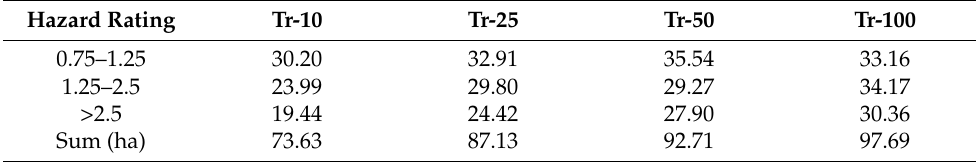
Figure 13. Flood hazard maps based on different return period rainfall events. Table 2. The allocated area (ha) to the different classes of flood hazard (moderate to extreme).